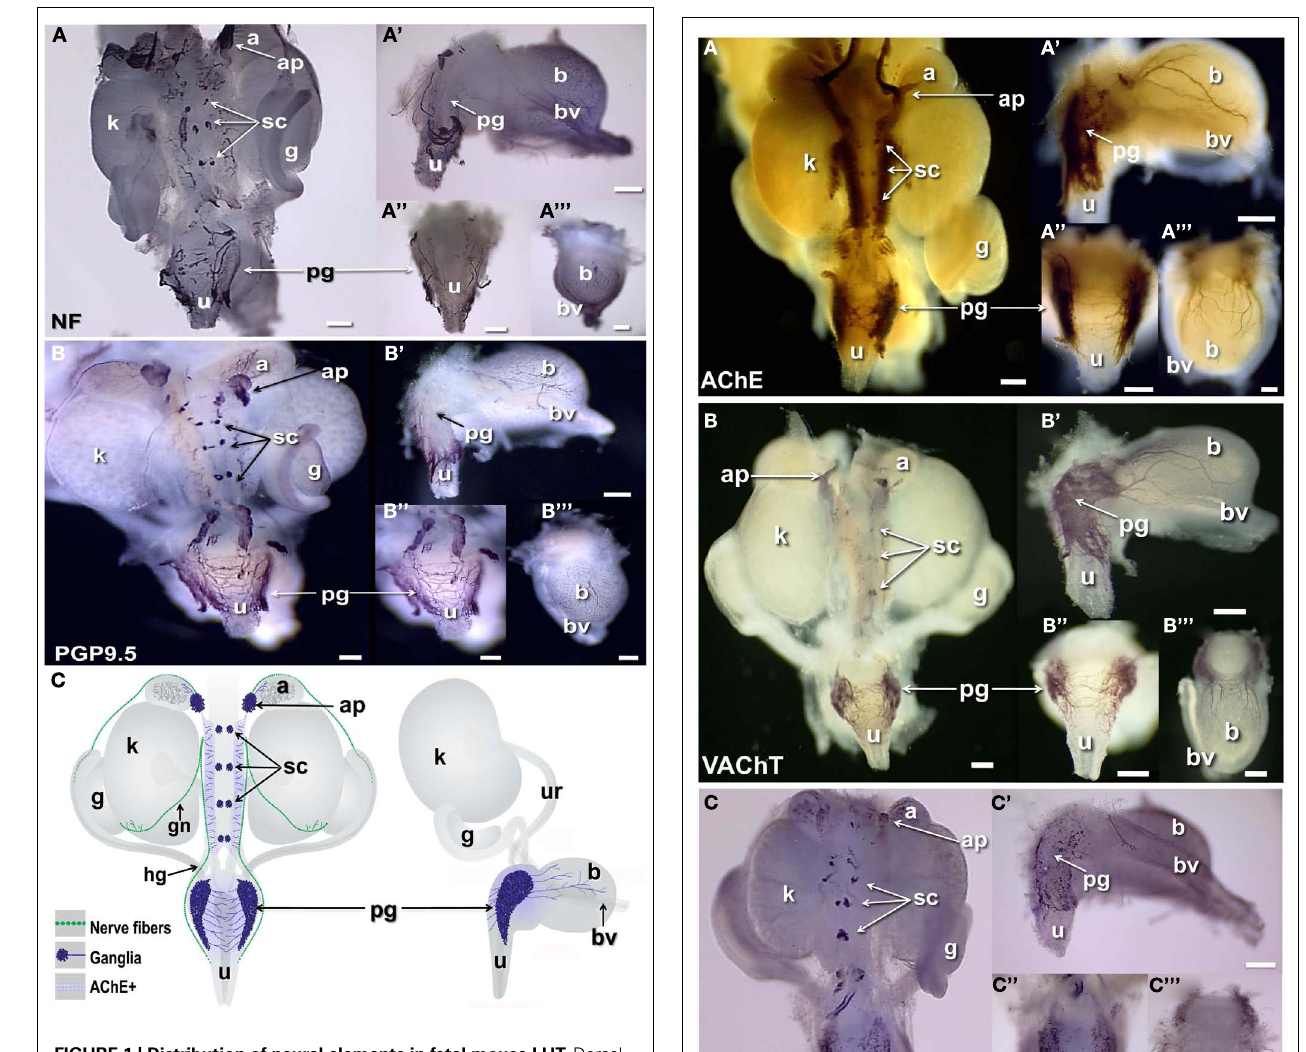
FIGURE 1 | Distribution of neural elements in fetal mouse LUT. Dorsal, lateral, and anterior views of whole-mount urogenital tract (UGT) processed to detect neuronal antigens are shown. (A) Positions of peripheral ganglia and nerve fibers are labeled by whole-mount IHC in female 15.5dpc fetal LUT stained for neurofilament (NF). (B) Whole-mount IHC for PGP9.5 similarly stains both peripheral ganglia and nerve processes at this stage in female LUT. Dorsal views of the intact UGT are shown for each antigen. Lateral views of dissected bladder with attached urethra are shown (A (cid:48) ,B (cid:48) ) . Dorsal views of the urethra (A (cid:48)(cid:48) ,B (cid:48)(cid:48) ) and anterior views of the bladder ( A (cid:48)(cid:48)(cid:48) ,B (cid:48)(cid:48)(cid:48) ) show relative positions of the pelvic ganglia to these structures. (C) Schematic diagrams of fetal mouse UGT at 15.5dpc summarize elements of autonomic innervation detected by IHC in dark blue. Axonal processes of efferent innervation that are accompanied by NC-derived peripheral glia are shown in green. In dorsal views (left), the adrenal plexus extends processes into the NC-derived medulla (dark gray) of the adrenal. Sympathetic chain ganglia at this stage reside as tight clusters medially between the kidneys. Neurites from bilateral pelvic ganglia flanking the urethra extend processes toward the center of the dorsal urethra.When viewed laterally (right) neurites also extend from pelvic ganglia and out toward the bladder dome along blood vessels that flank the bladder. (a, adrenal; ap, adrenal plexus; b, bladder; bv, blood vessel; g, gonad; gn, gonadal nerve; hg, hypogastric nerve; k, kidney; pg, pelvic ganglia; sc, sympathetic chain; u, urethra; ur, ureter; scale bar = 300 µ m).